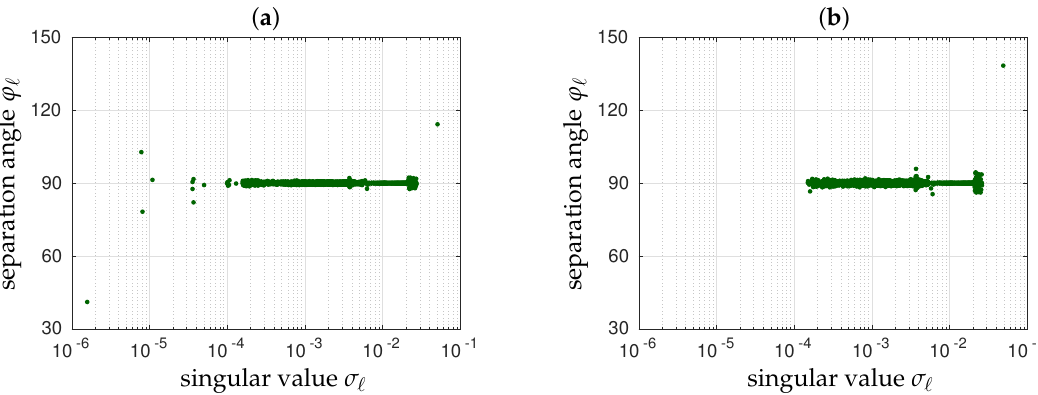
Figure 13. Separation angles ϕ (cid:96) between the singular vectors V (cid:96) of (cid:101) G and the brightness temperature maps (cid:101) T corresponding to the apodized maps (cid:101) T of Figure 9 retrieved when complex visibilities V are blurred by an additive Gaussian noise ∆ V with standard deviation set to 0.1 K for two values of the shortest spacing of the cross-shaped array shown in Figure 4: ( a ) d = 0.69 λ and ( b ) d = 0.71 λ . Only the first 13,861 largest singular values shown in green in Figure 5 are reported here inasmuch as the